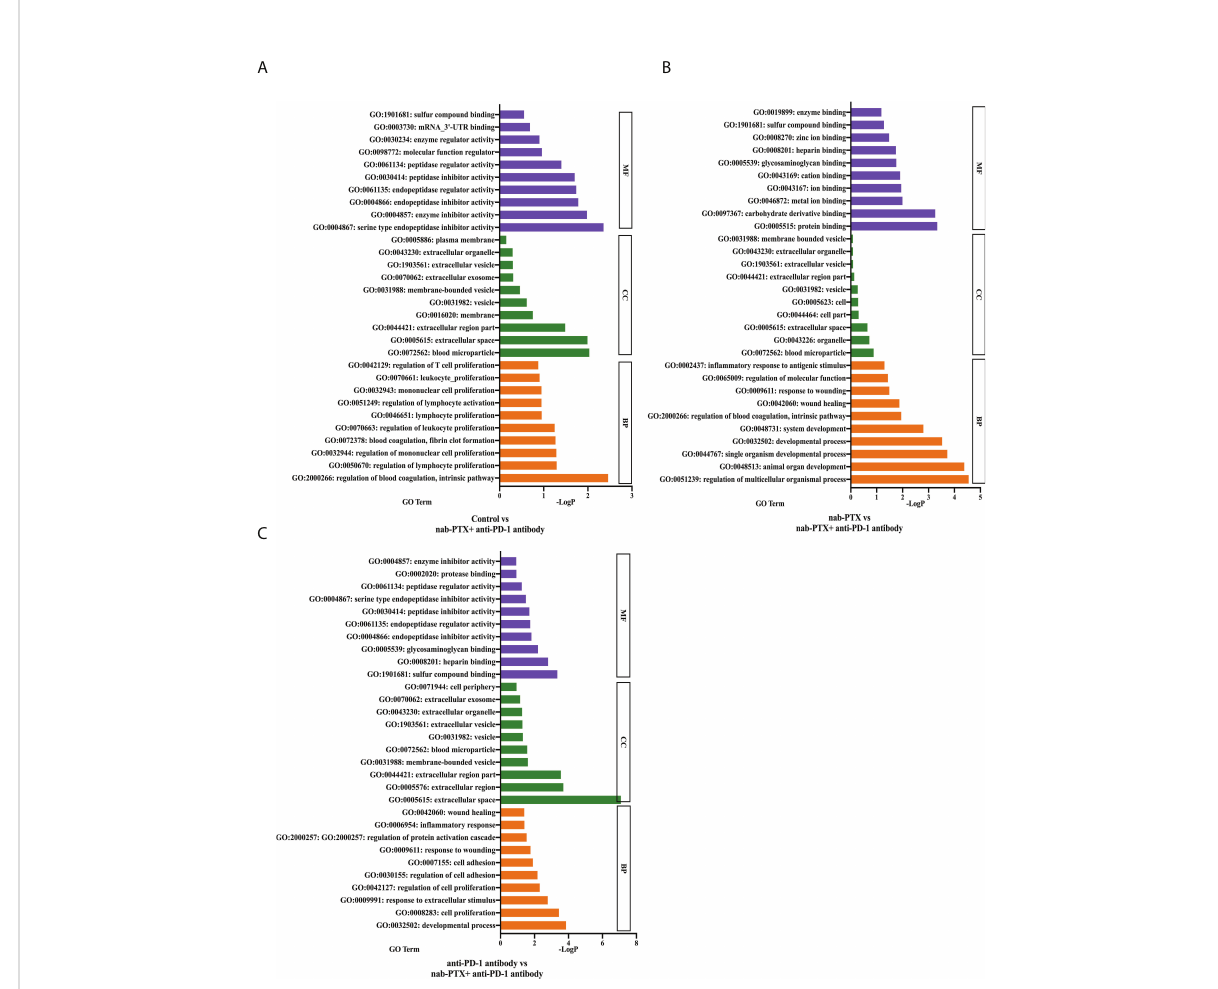
FIGURE 7 GO analysis of the functional classi fi cation of the target gene. The top 10 enriched GO terms of the Serpinc1 gene in molecular function (MF), cellular component (CC), and biological process (BP) in the comparison between (A) the control and the combination group, (B) nab-PTX and the combination group, and (C) anti-PD-1 antibody and the combination